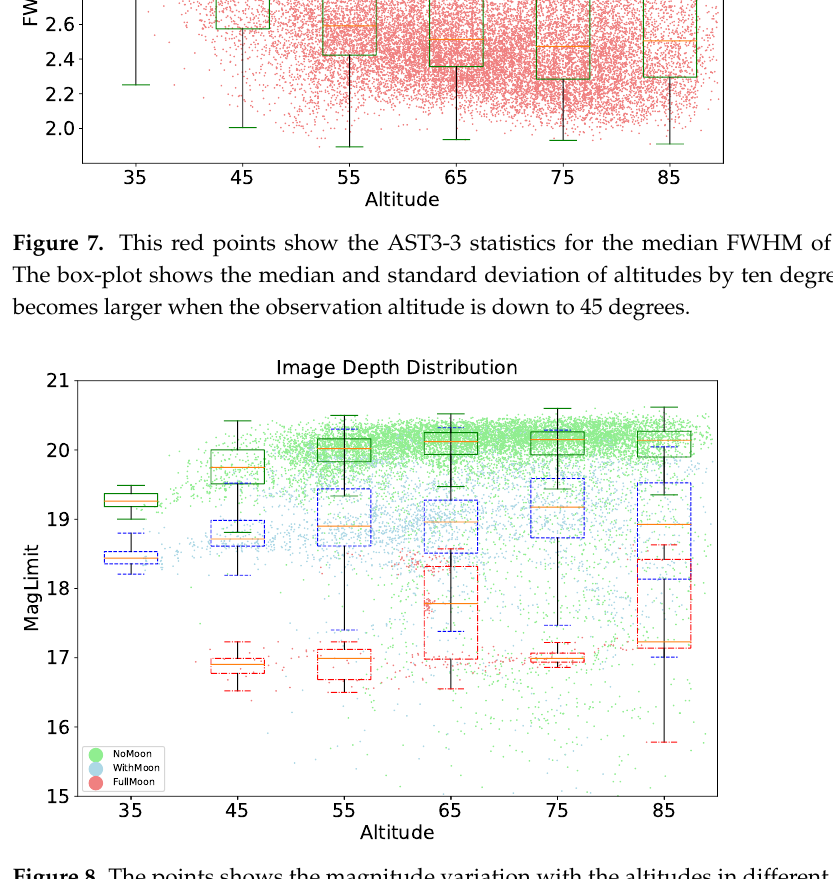
Figure 8. The points shows the magnitude variation with the altitudes in different moon affections. The box-plot shows the median and standard deviation of altitudes by ten